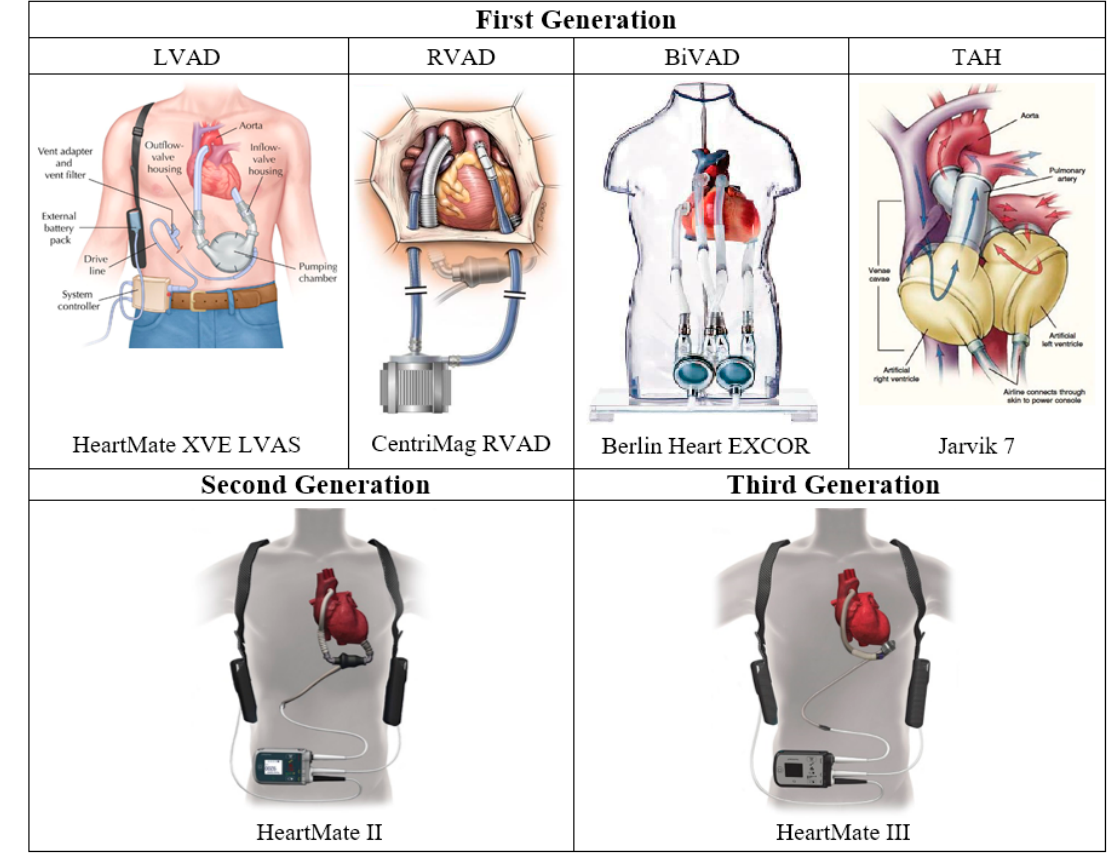
Figure 3. Examples of first, second, and third generation cardiac assist devices [40–46].